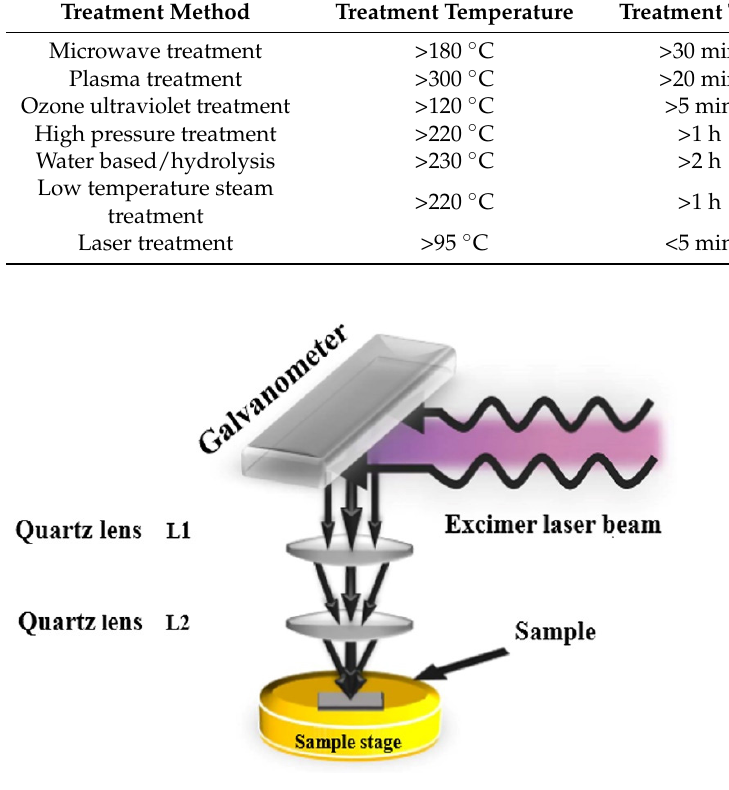
Figure 3. Schematic diagram of laser treatment device [48].